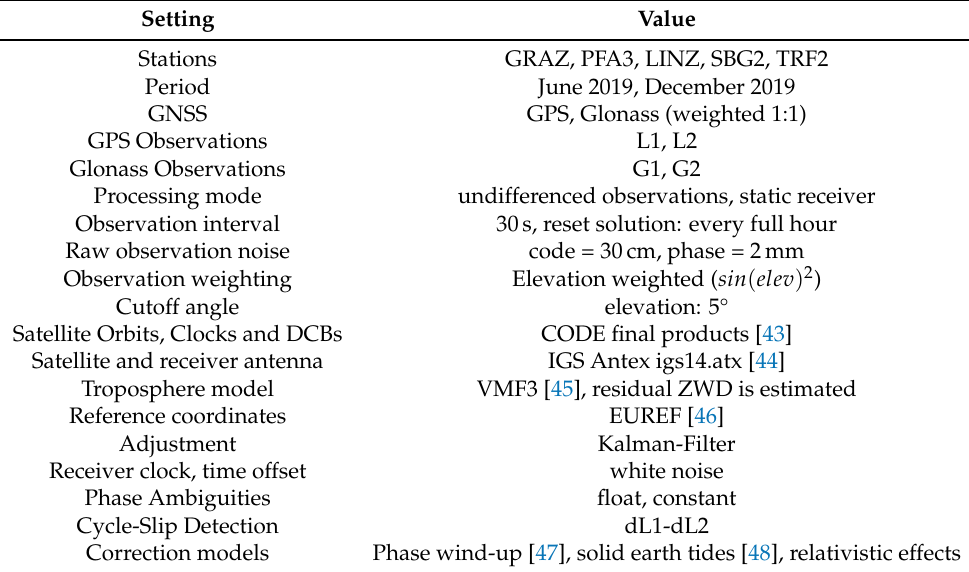
Table 3. General processing settings used for PPP